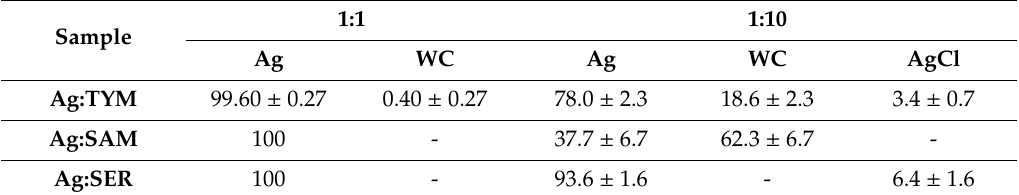
Table 1. Phase analysis of washed Ag:plant 1:1 and 1:10 samples (phase content is in %). Sample